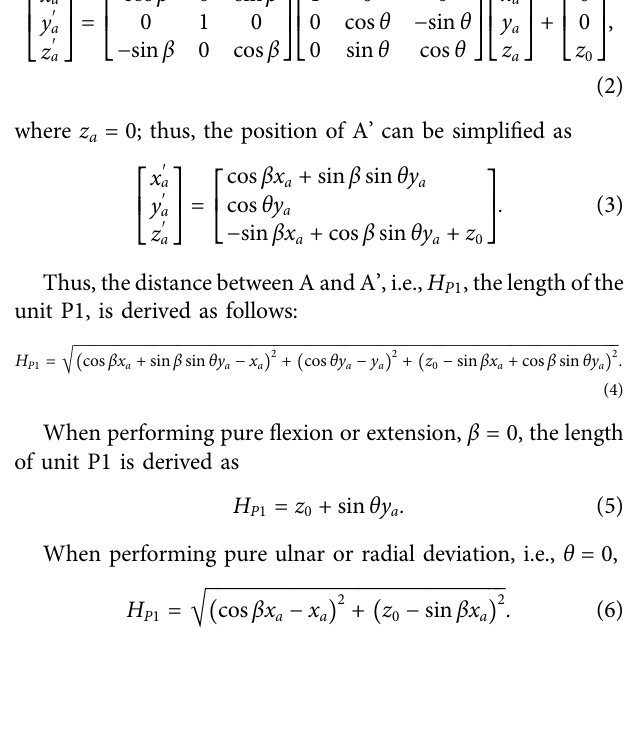
Frontiers in Robotics and AI |